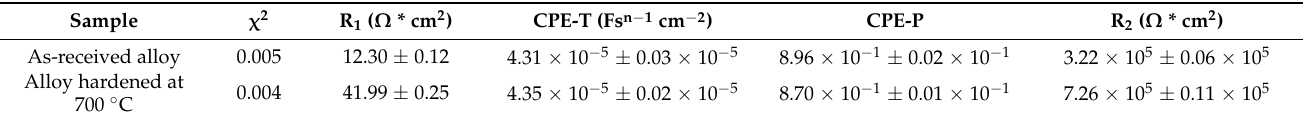
Figure 10. Equivalent circuit used for fitting EIS data. Table 2. Chi-squared (χ 2 ) values obtained by fitting equivalent electrical circuit with Z View software and electrochemical parameters for the as-received and treated titanium alloy.